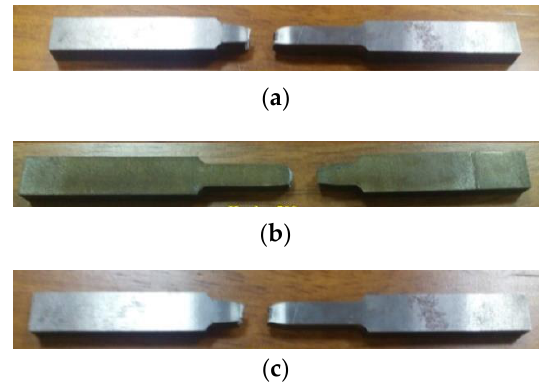
Figure 6 . After tensile test fracture condition for: ( a ) RHA; ( b ) Ar500; and ( c ) Al7075-T6.